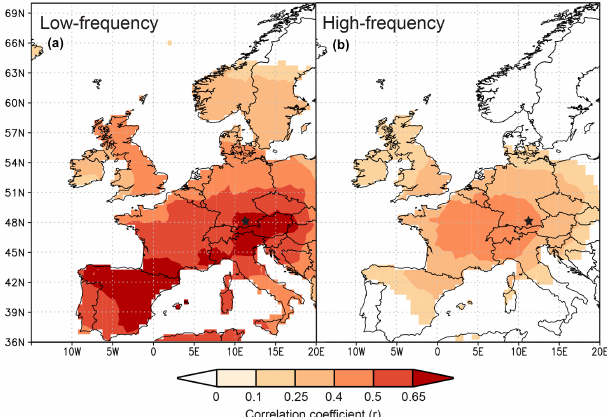
Figure 5. Spatial correlations between summer temperatures (CRU TS4.04) and δ 13 C LM_RL anomalies (a) and δ 13 C LM_high-frequency indices (b) from 1916–2015. Black star marks the Hohenpeißenberg in